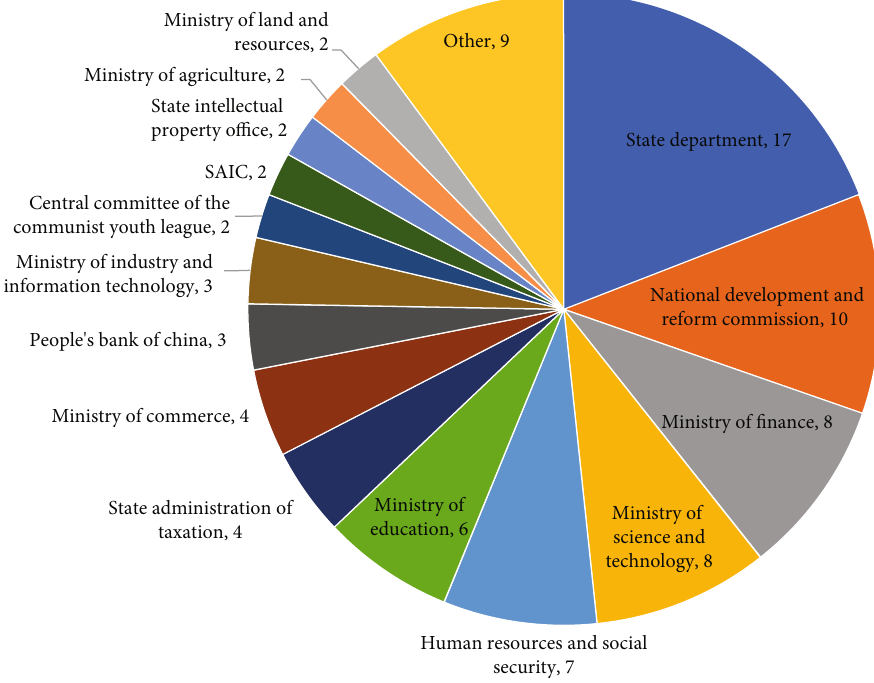
Figure 5: Departmental distribution of entrepreneurship policies promulgated in higher vocational colleges.